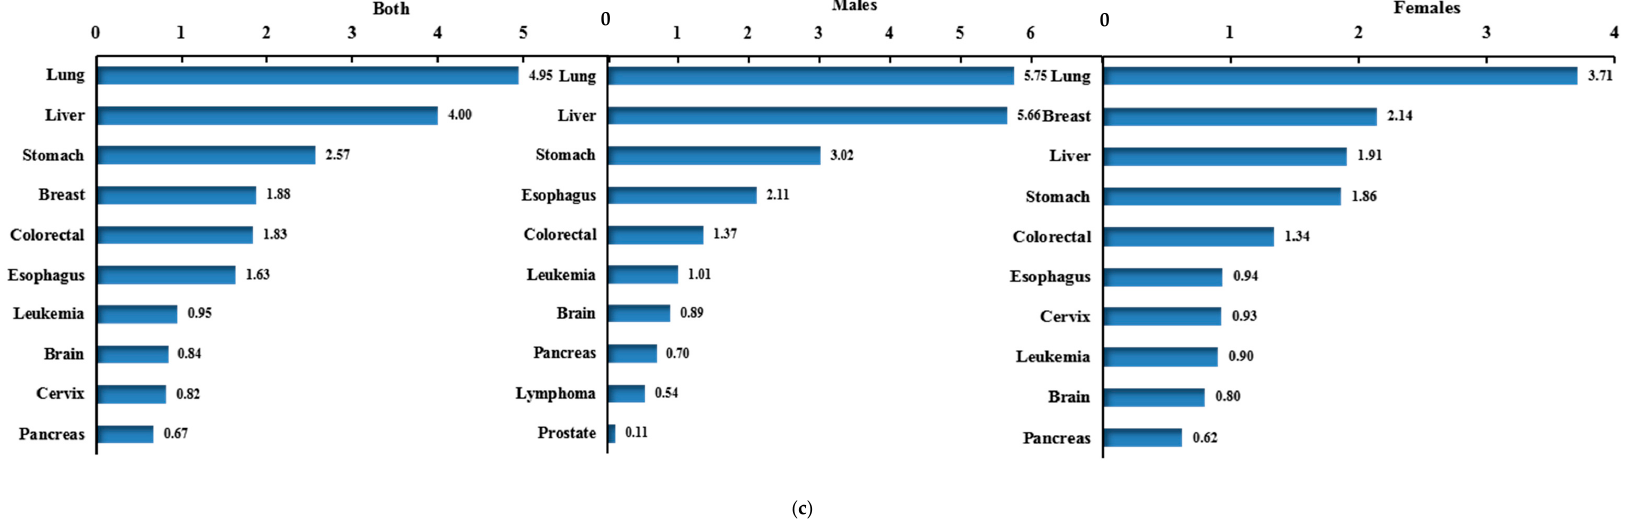
Figure 2. Ranks of high-death-risk cancers PYLL rate in China by region and gender, 2013. ( a ) urban; ( b ) rural; ( c ) both.